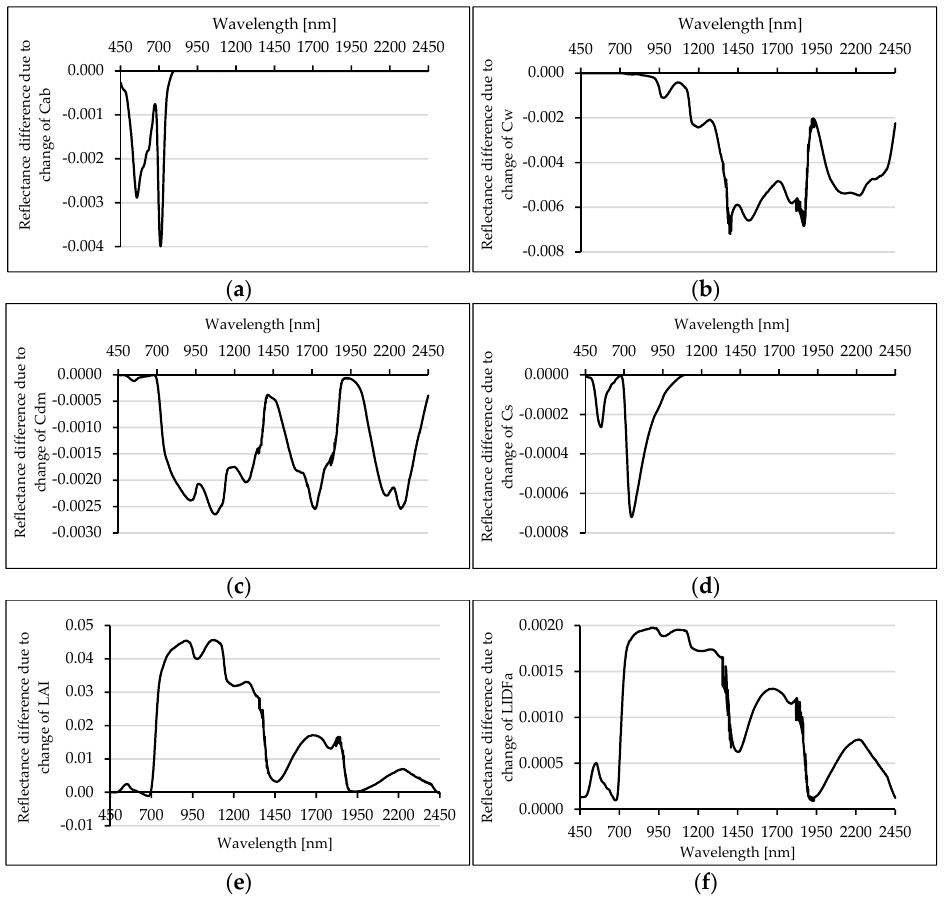
Figure 8. The partial derivative of canopy reflectance simulated by RTMo to each of the input parameters. ( a ) Cab; ( b ) Cw; ( c ) Cdm; ( d ) Cs ( e ) LAI; ( f ) LIDFa.